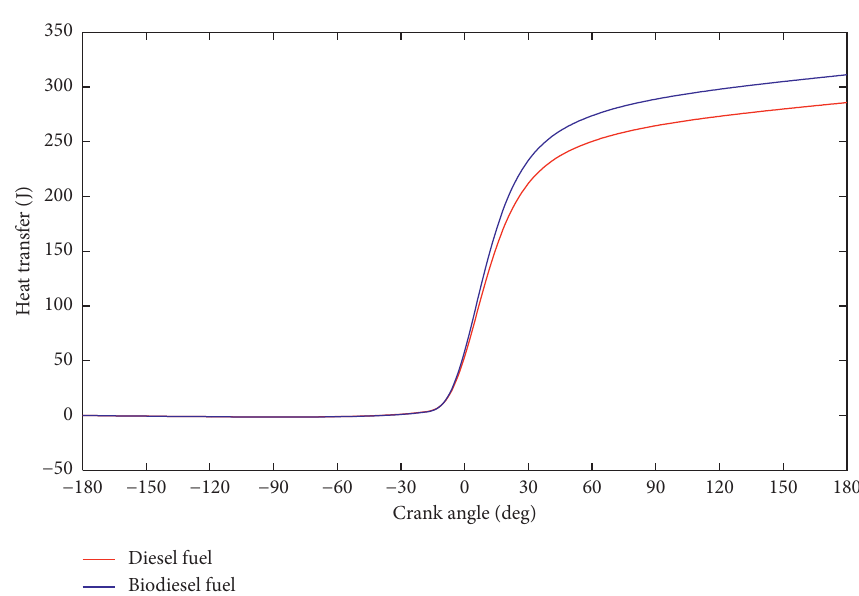
Figure 6: Heat transfer comparison of biodiesel and diesel